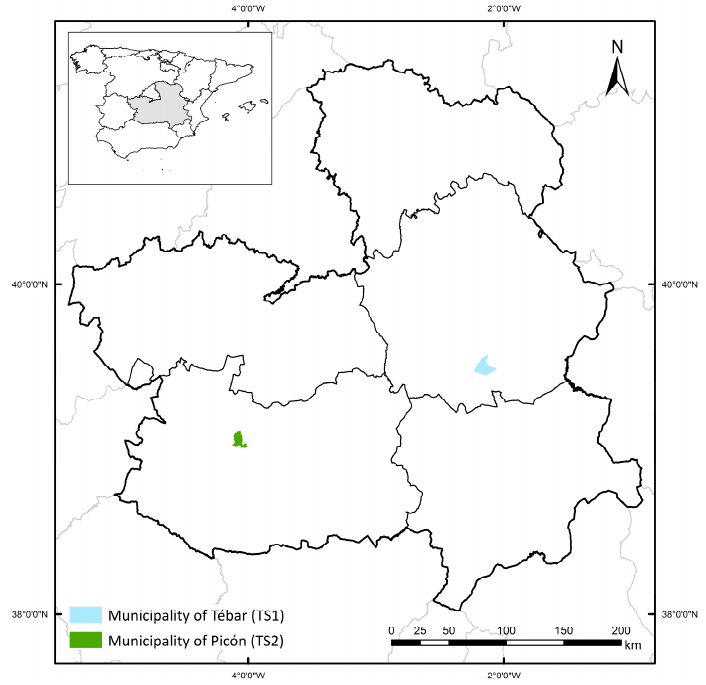
Figure 6. Selected areas for LiDAR processing evaluation.